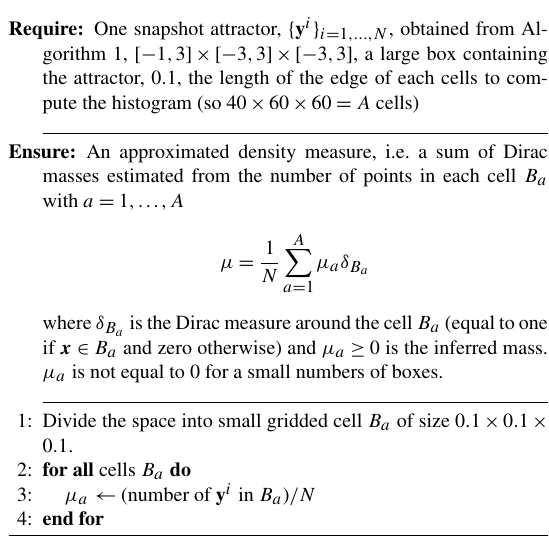
model. (b) summer snapshot attractor of the Lorenz 84 model. Each of 10000 points Figure 2. (a) winter snapshot attractor of the Lorenz84 is the solution at time 5 τ